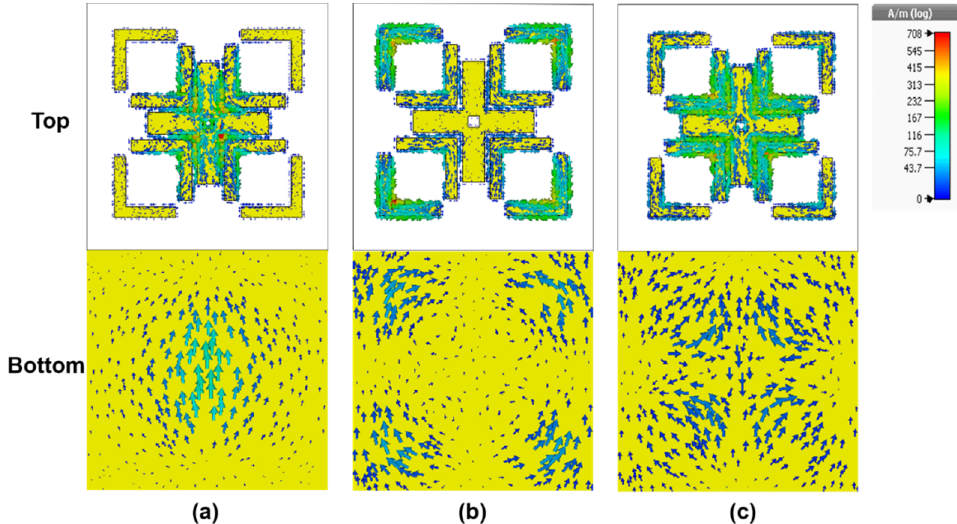
Figure 4. Surface-current distribution on the MA structure when d = 0.5 mm at absorption frequencies of ( a ) 6.80, ( b ) 8.36 and ( c ) 8.80 GHz.